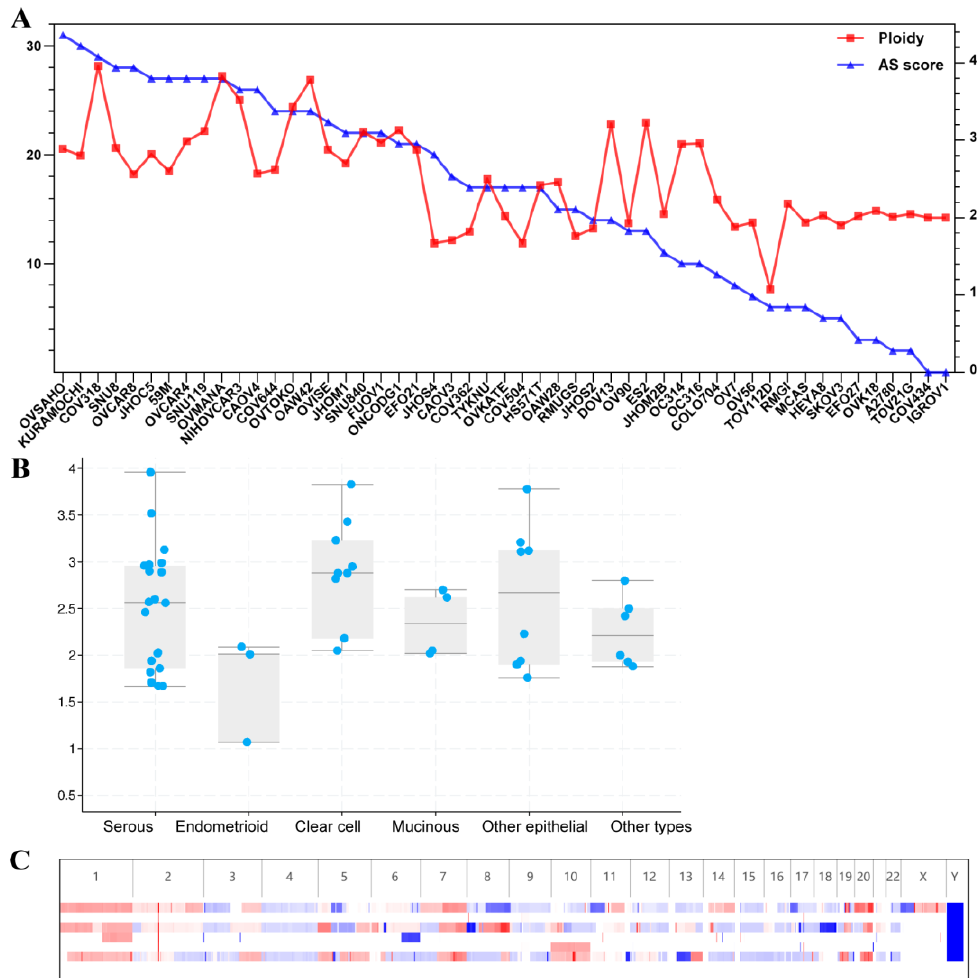
Figure 1. Ploidy and aneuploid score of 51 ovarian cancer cell lines from the CCLE. ( A ): Ploidy and aneuploid score of 51 ovarian cancer cell lines from the CCLE. The aneuploid score and ploidy value are obtained from cBioPortal on the basis of chromosome copy variations and ABSOLUTE estimation. ( B ): Comparison analysis of the ploidy value among different histological types (P = 0.138). Other epithelial: cell lines from cystadenocarcinoma type or adenocarcinoma without clear types; Other types: cell lines from granulosa cell tumor of mixed ovarian carcinoma. ( C ): Copy number variations of representative samples of diploid and aneuploid cell lines. Terms from top to bottom are COV318 (AS = 29, ploidy value = 3.96); COV434 (AS = 0, ploidy value = 2.00); KURAMOCHI (AS = 30, ploidy value = 2.80); A2780 (AS = 2, ploidy value = 2.01); TOV21G (AS = 2, ploidy = 2.05) and OVSAHO (AS = 31, ploidy value = 2.89).